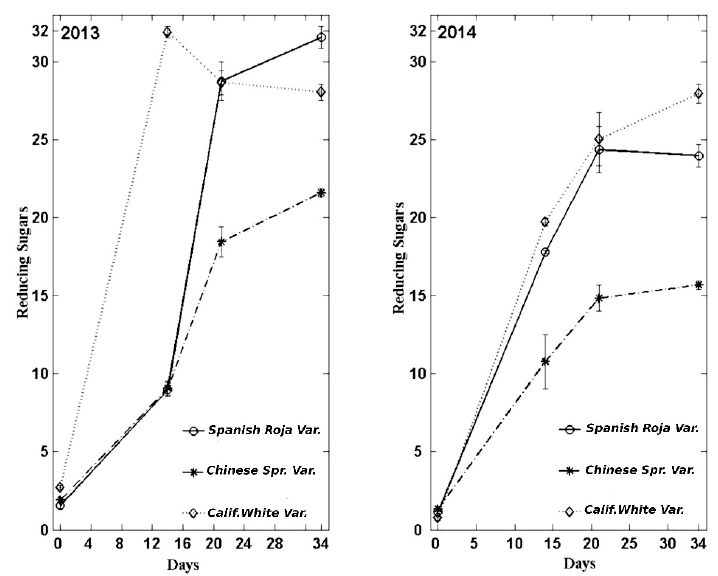
Figure 2. Evolution of the reducing sugar content (g / kg lyophilized sample) during the manufacture of black garlic with three varieties and two types of garlic: garlic aged one year and garlic recently harvested.